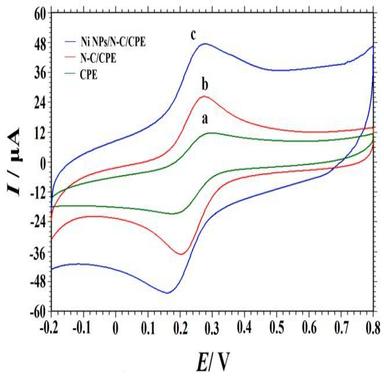
cyclic voltammograms of 1.0 mM K3 in 0.5 M KCl recorded on (a) CPE, (b) N-C/CPE, and (c) Ni NPs/N-C/CPE, scan rate: 0.1 V s − 1 .